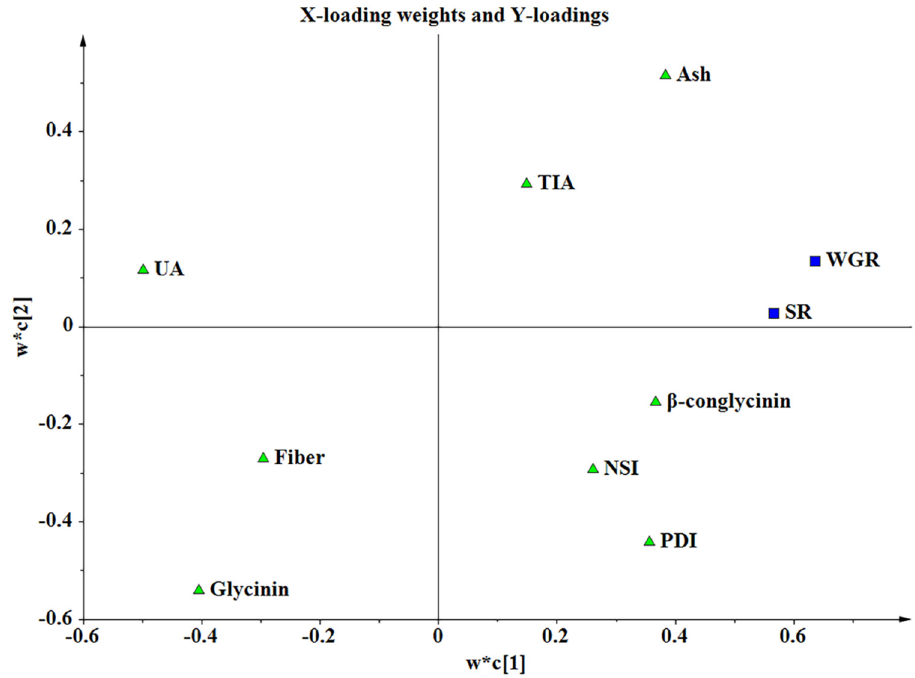
Figure 3. The PLS weights w * and c are for the first two components. The w *s are weights that combine the X variables; variables with large w * are situated far away from the origin (on the positive or negative side) on the plot; c are weights that combine the Y variables. This plot shows the correlation structure between X , ash, fiber, protein dispersibility index (PDI), nitrogen solubility index (NSI), urease activity (UA), trypsin inhibitor activity (TIA), glycinin, and β -conglycinin, and Y , survival rate (SR) and weight gain rate (WGR).